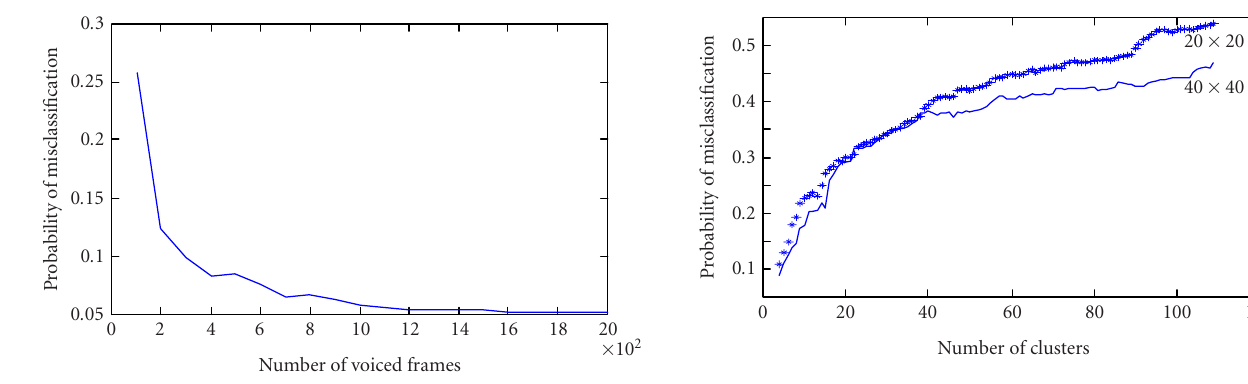
Figure 4: Probability of misclassification versus the number of voiced frames used for training.